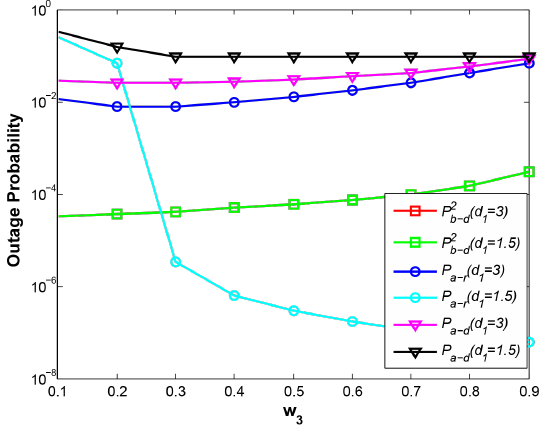
Figure 5. OP vs. w 3 .